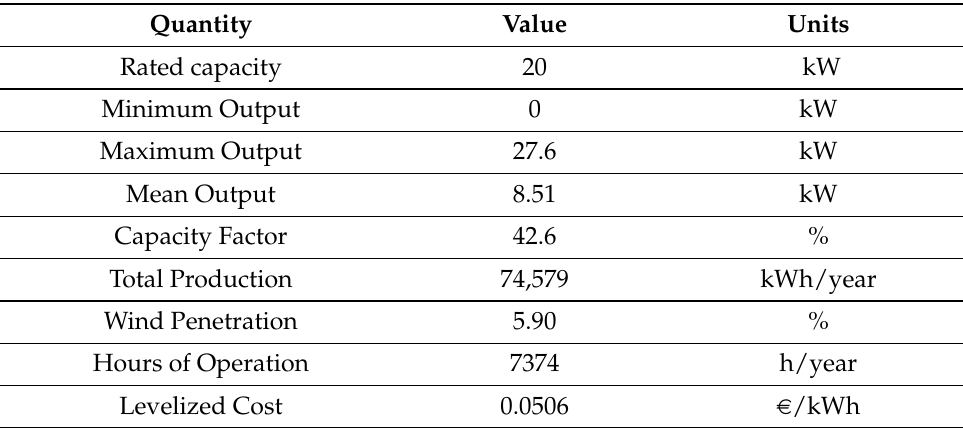
Figure 19. Wind power output Case 1 ( upper figure ) and Case2 ( bottom figure ) Scenario 3. Table 26. Aeolos-H (10 kW) Scheme Simulation Results Case 2 Scenario